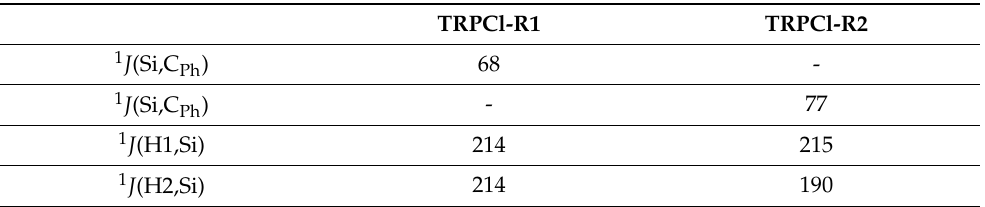
Figure 2. 1 H NMR spectra for chloroform- d solutions of TRPCl, which exists in the form of two rotamers, TRPCl-R1 and TRPCl-R2 [124]. Copyright Royal Society of Chemistry.